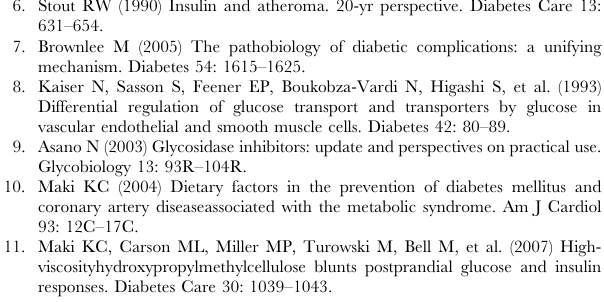
Figure S1 ntMGAM-S1-b interactions. Schematic represen- tation of electrostatic and hydrogen bond interactions between the ntMGAM side chain residues and S1-b (PDB entry 2QMJ). (JPG) Figure S2 The mass spectrum of the structure of S3-b. (PDF) Figure S3 The mass spectrum of the structure of S2-b. (PDF) Figure S4 The 1 H-NMR of the structure of S3-b. (PDF) Figure S5 The 1 H-NMR of the structure of S2-b. (PDF) Chart S1 The structure of acarbose. Numbers show the location of carbons. (TIF) Chart S2 The main components of active plants. (TIF) Chart S3 The structure of a) S1-b b) S2-b c) S3-b. Numbers show the location of carbons.